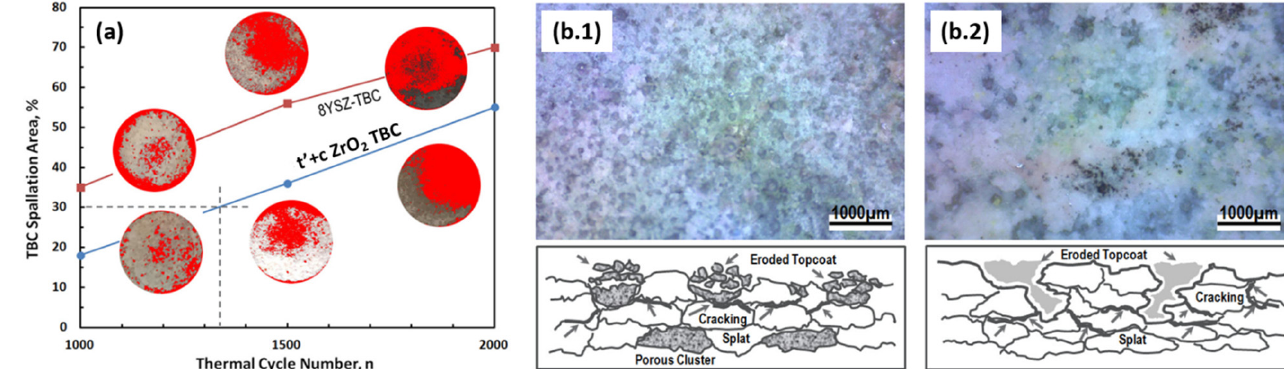
Figure 9. Thermal shock behavior of two-phase TBC in burner rig test: ( a ) Plot of TBC spallation area percentage versus the thermal cycling number; ( b.1 ) schematic failure modes of the dual-phase TBC after 2000 cycles; ( b.2 ) failure modes of the single-phase 8YSZ-TBC after 2000 cycles.